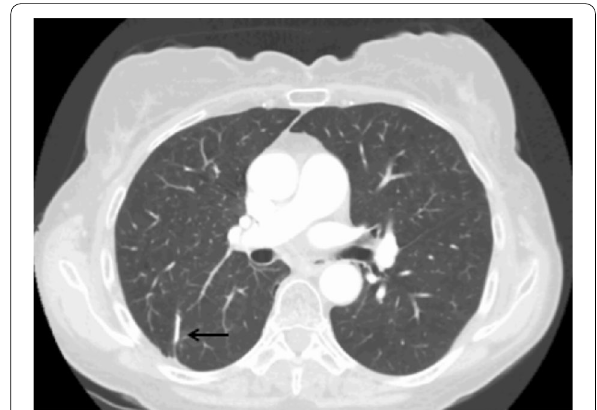
Fig. 1 Wedge resection. Axial CT image (parenchymal window) shows a linear increased density due to a parenchymal staple line (black